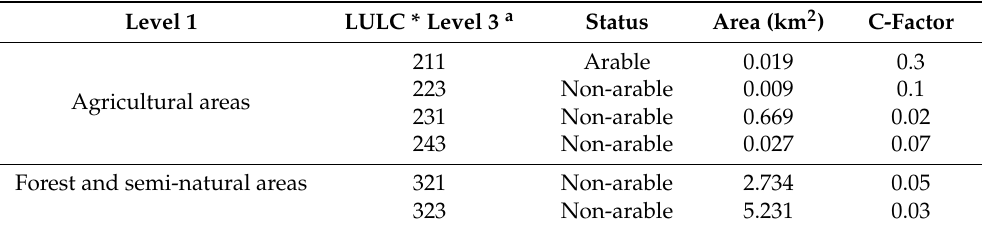
Table 4. Land use classification of the Platana Dam basin delineation and respective RUSLE C-factor